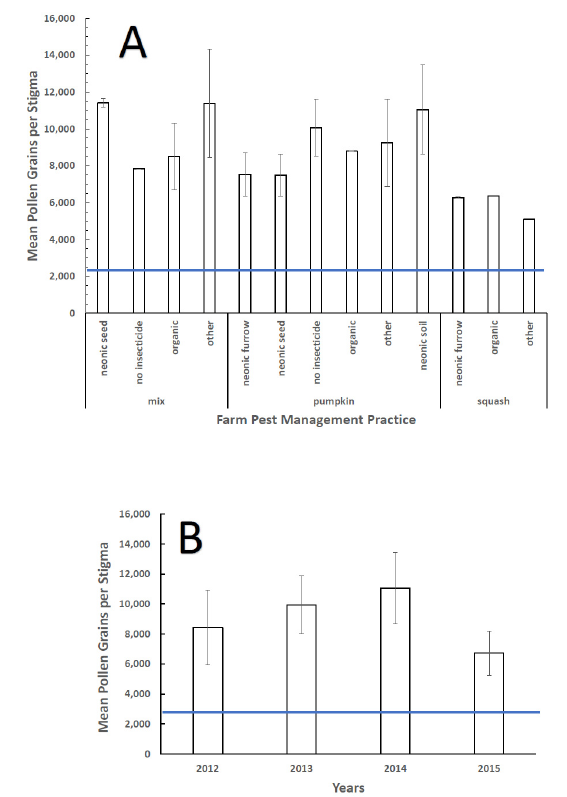
Figure 1. Mean pollen grains deposited per stigma on female flowers of pumpkin and winter squash. ( A ) By pest management practice and crop mix; ( B ) By year. Blue line at 2300 grains indicates the number of grains su ffi cient for full pollination of pumpkins based on the current study. Neonic seed = seed treatment with Farmore ® , a proprietary combination of thiamethoxam and fungicides (Syngenta Crop Protection Greensboro, NC, USA); neonic furrow = application of imidacloprid (Admire ® Bayer Crop Protection, Research Triangle Park, NC, USA) or thiamethoxam (Platinum ® Syngenta Crop